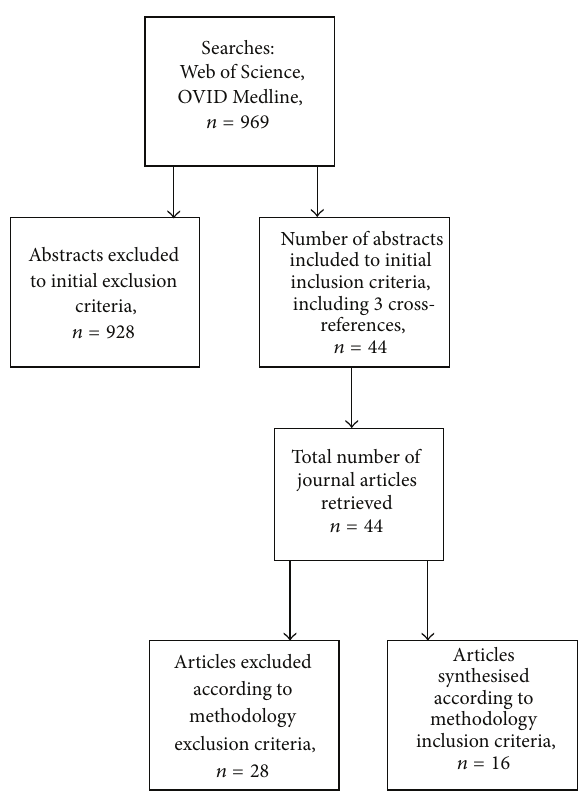
Figure 1: Summary of data